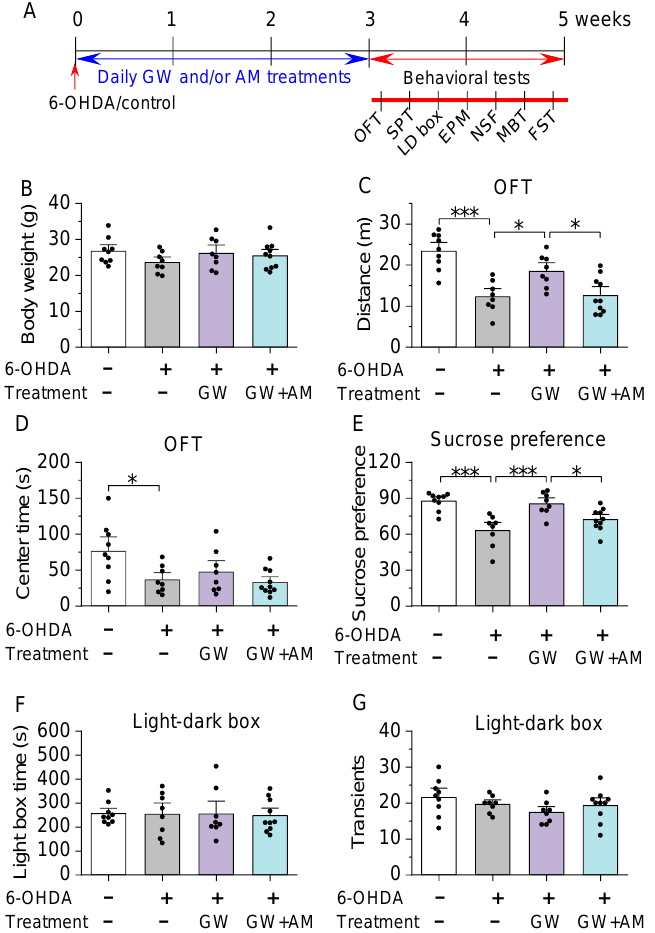
Figure 5. GW treatment attenuated 6-OHDA-induced deficits in the open field test (OFT), sucrose preference test (SPT), and light – dark box (LDB) test. ( A ) Timeline of 6-OHDA injection, drug treat- ments, and behavioral tests. ( B ) Neither 6-OHDA or drug treatments had a significant effect on body weight ( p > 0.05). ( C , D ) In the OFT, 6-OHDA injection reduced total distance traveled (( C ) *** p < 0.001; n = 8 – 9 mice) and time spent in the center of the chamber (( D ) * p = 0.030; n = 8 – 9 mice) com- pared to the controls. GW treatment prevented the reduction in distance traveled (* p = 0.027; n = 8 – 8 mice), and the effect of GW was blocked by AM630 co-treatment ( p = 0.027; n = 8 – 10 mice). How- ever, neither GW alone ( p = 0.867; n = 8 – 8 mice) or in combination with AM630 ( p = 0.689; n = 8 – 10 mice) had a significant effect on time spent in the center of the chamber. ( E ) In the SPT, 6-OHDA injection significantly reduced sucrose preference (*** p < 0.001; n = 8 – 9 mice) relative to the control. GW treatment prevented the reduction in sucrose preference (*** p < 0.001; n = 8 – 8 mice), an effect that was blocked by AM630 (* p = 0.040; n = 8 – 10 mice). ( F , G ) In the LDB, neither 6-OHDA injection or treatment with GW and/or AM had a significant effect on time spent in the light compartment (( F ) p > 0.05) or the number of transitions between the light and dark areas (( G ) p > 0.05). Similar to the OFT and LDT, a decrease in entries into and/or time spent in the open arms of the elevated plus-maze indicates anxiogenic-like behavior [59,60]. One-way